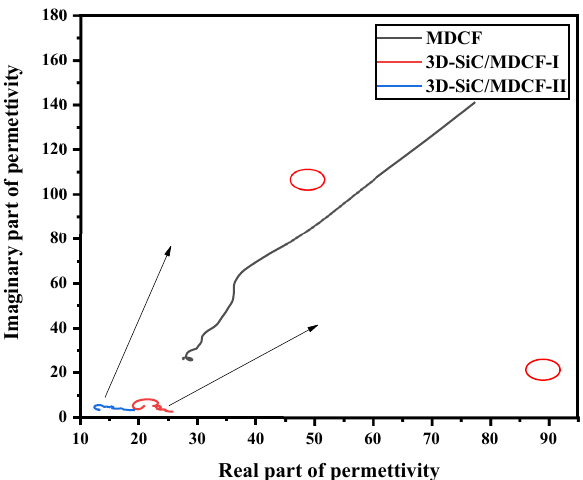
Fig. 6 Cole-Cole plots of MDCF, SiC/MDCF-I, and 3D-SiC/MDCF-II.